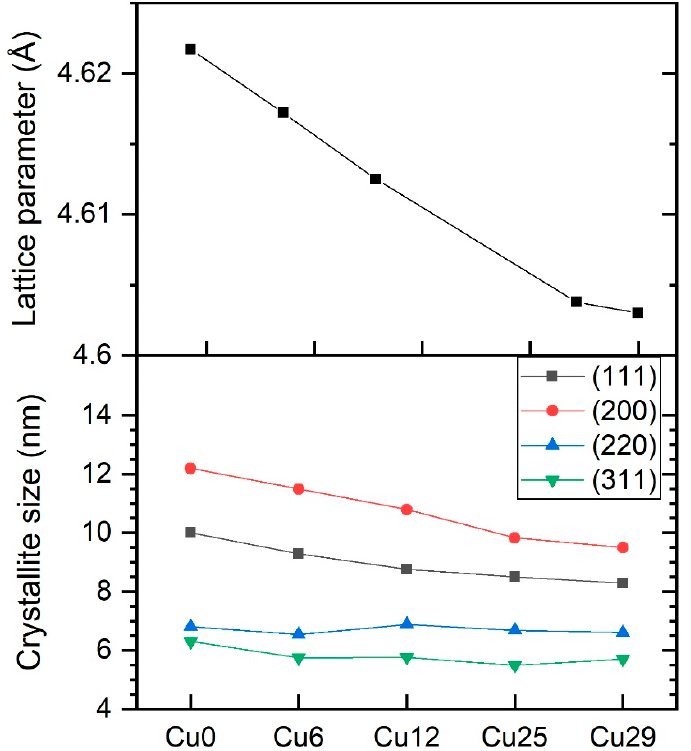
Figure 4. The lattice parameter, and crystallite size of ZrN-Cu coatings with different copper contents.